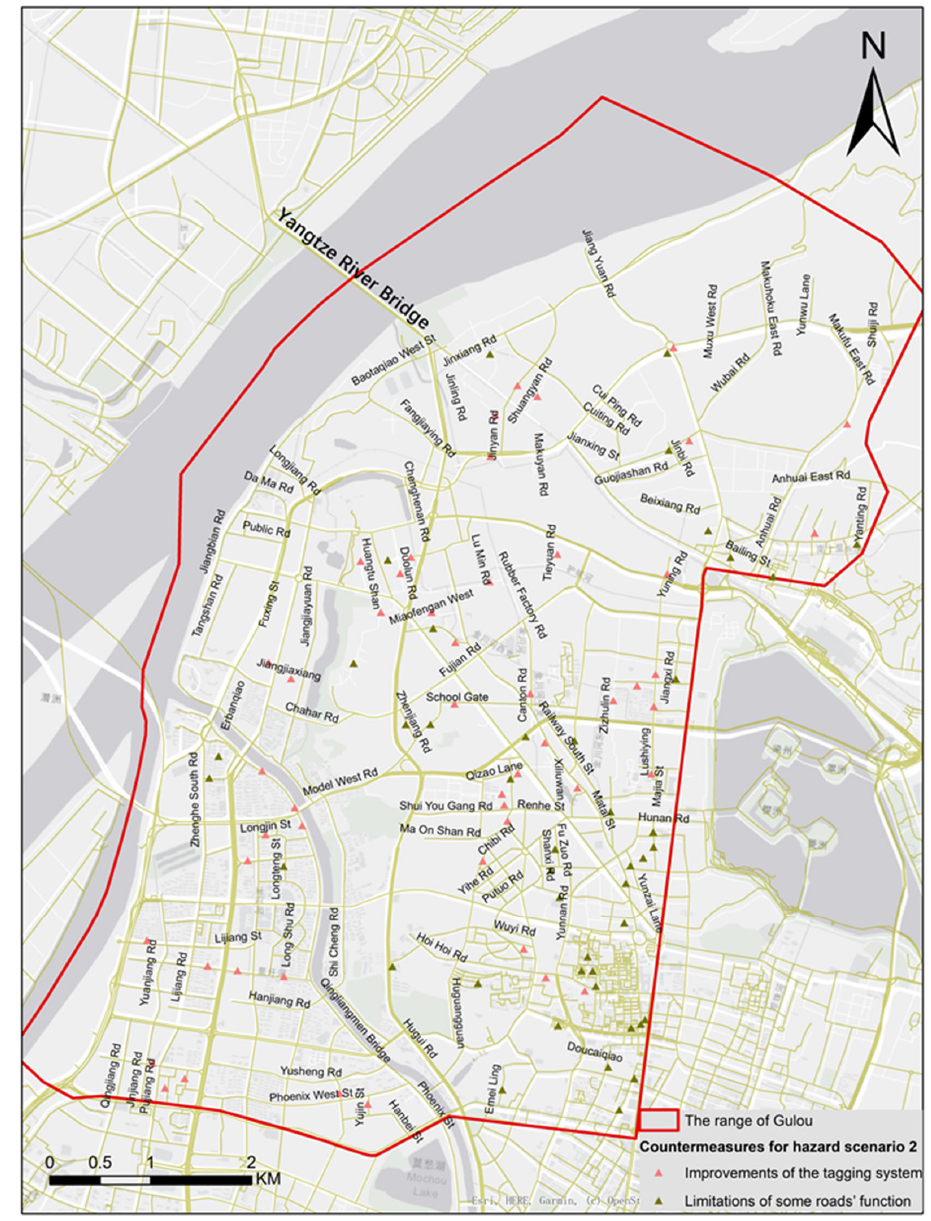
Figure 20. The countermeasures for HS2 in specific road sections.